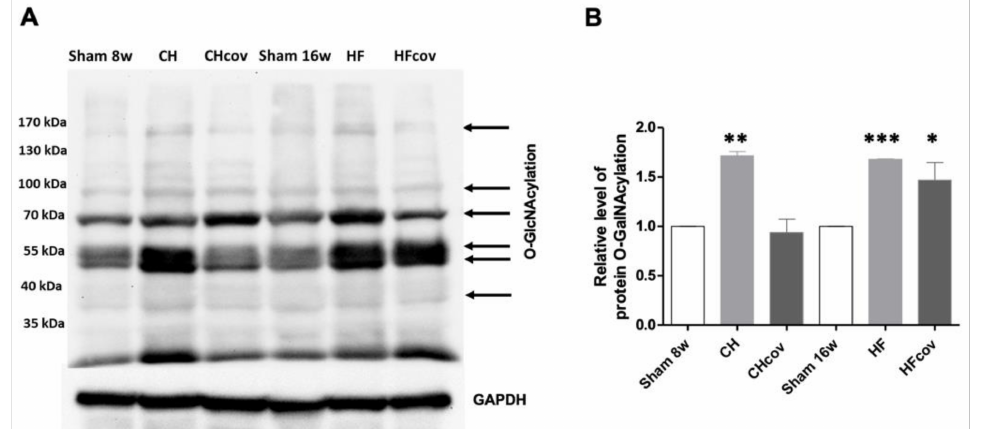
Figure 5. Patterns of protein O -GlcNAcylation in the left ventricles of volume-overloaded rats in the compensated hypertrophic (CH) and heart failure (HF) phases and in volume-overloaded rats with correction of volume overload in the CH (CH COV ) and HF phases (HF COV ) were analyzed by immunoblotting by using a pan-specific CTD 110.6 anti- O -GlcNAc antibody. Arrows indicate bands that show altered O -GlcNAcylation labeling in volume-overloaded rats compared with the corresponding sham controls ( A ). The levels of protein O -GlcNAcylation were quantified relative to glyceraldehyde-3-phosphate dehydrogenase (GAPDH) by densitometry ( B ). n = 4 per group. *, **, and *** denote p < 0.05, p < 0.01, and p < 0.001,